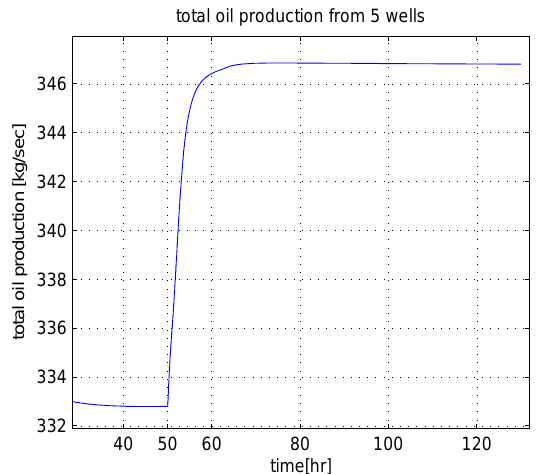
Figure 5: Total oil production without optimization from about 332.5 kg/sec (non-optimal production) to about 346.5 kg/sec (optimal production) as shown in Figure 6.